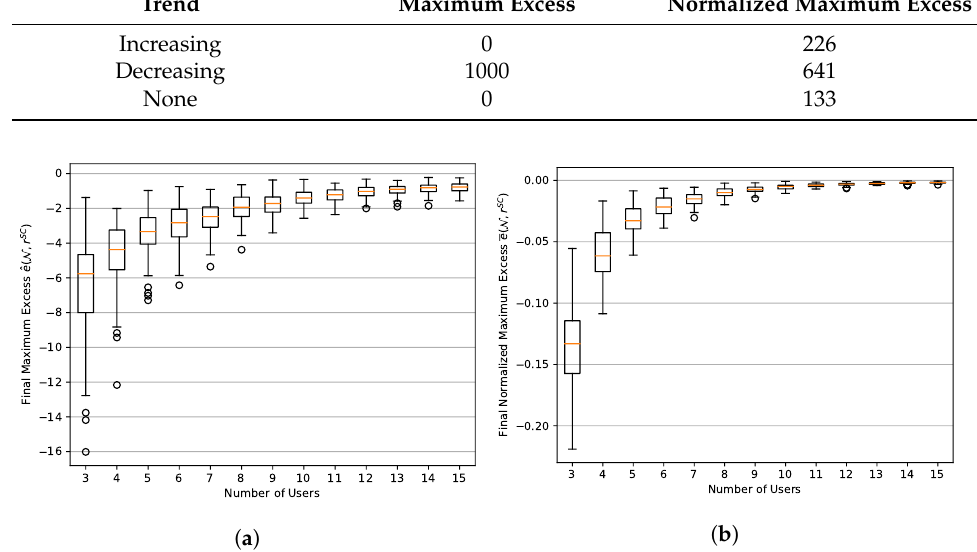
Figure 10. Boxplot of final maximum excess ( a ) and normalized maximum excess ( b ) with Shapley– core in 1000 trials broken down by the number of users in the